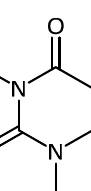
Figure 16. Structure of caffeine.